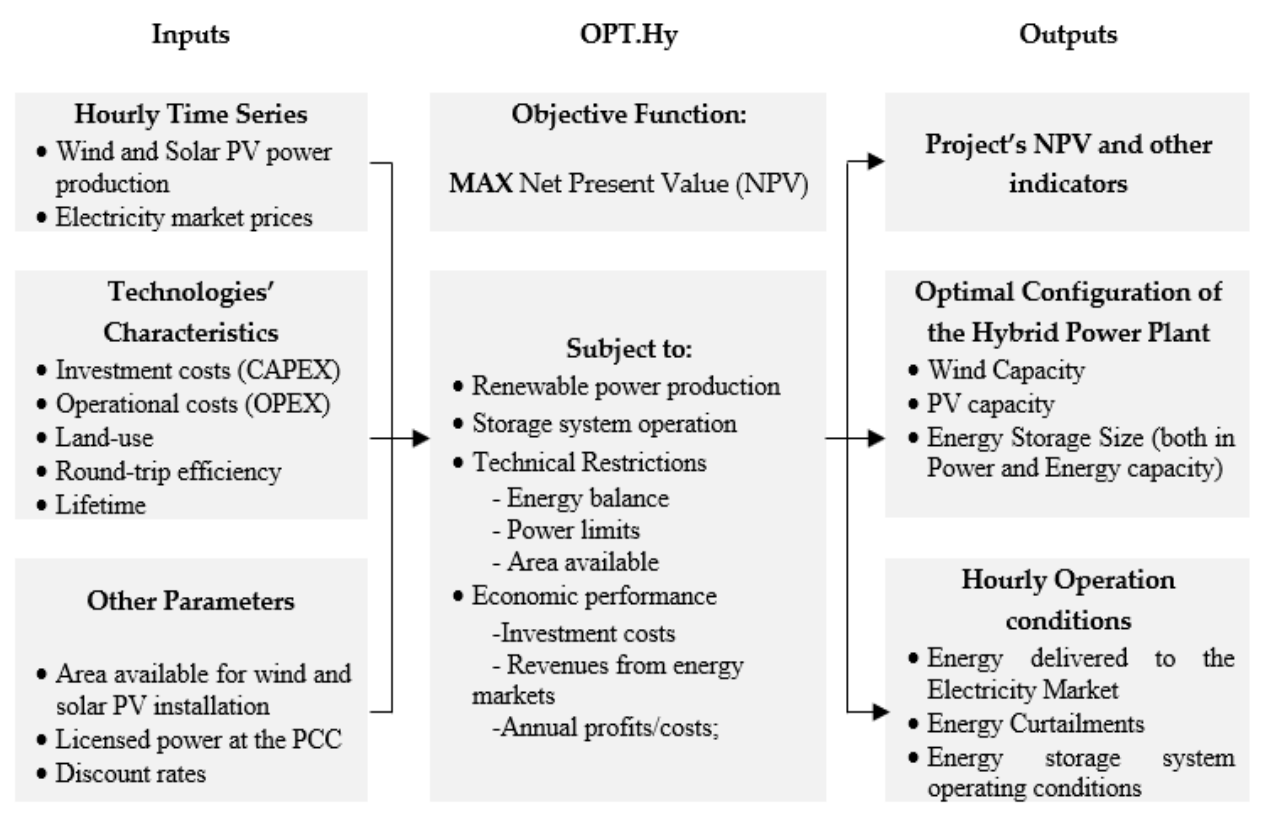
Figure 3. Schematic representation of the OPT.Hy tool.